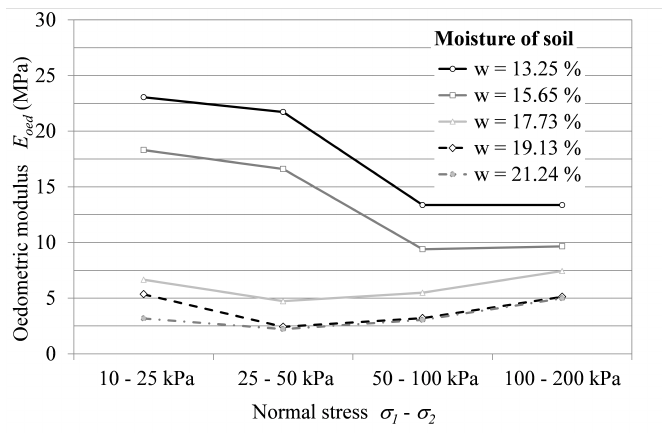
Figure 3. Dependence of normal stress and moisture on deformation characteristics of soil.